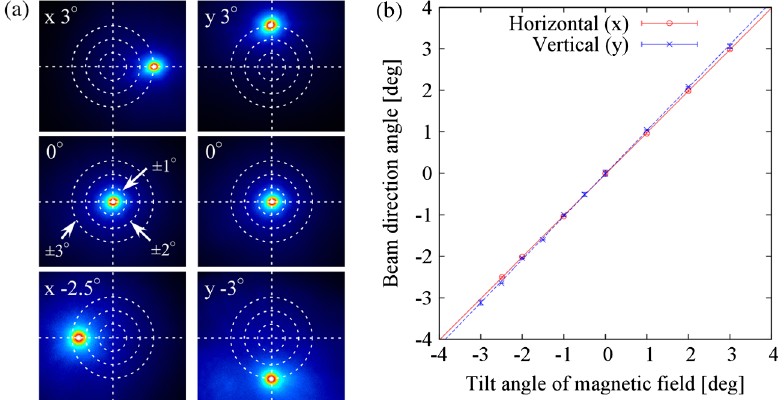
FIG. 5. (a) Electron beam profiles on the phosphor screen and (b) the beam pointing obtained by irradiating the laser pulse with the high-intensity prepulse (ASE level ∼ 10 12 W = cm 2 ) into the gas jet with the density ∼ 4 . 5 × 10 19 cm − 3 under tilted static magnetic